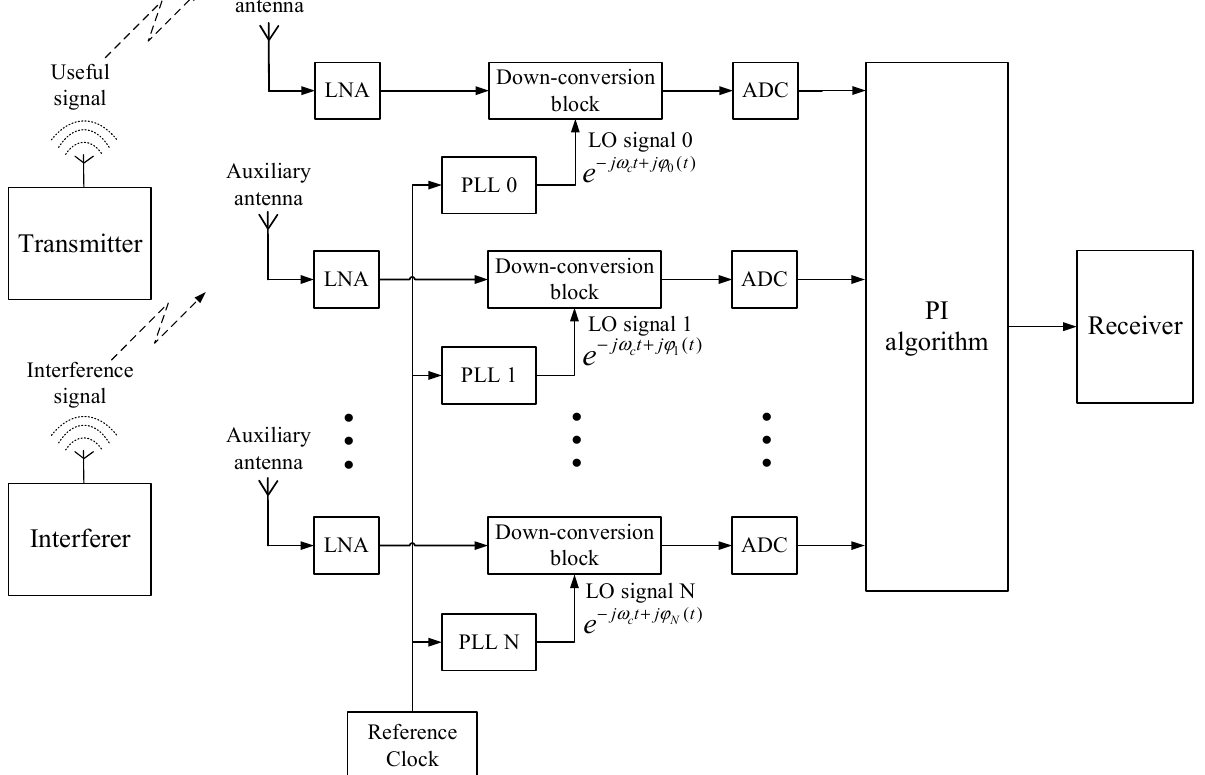
Figure 2. Block diagram of digital beamforming anti-jamming system based on the PI algorithm.